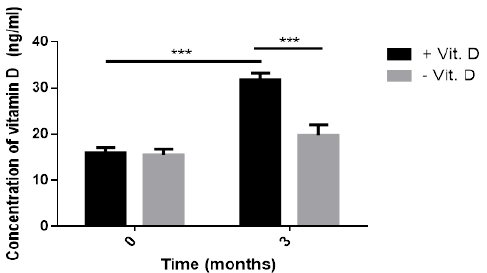
Figure 1. The serum level of vitamin D detected in the intervention group (+Vit. D, n = 48) and the comparative group ( − Vit. D, n = 44) before and after three-month supplementation. Results are presented as mean ± standard deviation (SD) (*** p < 0.001).